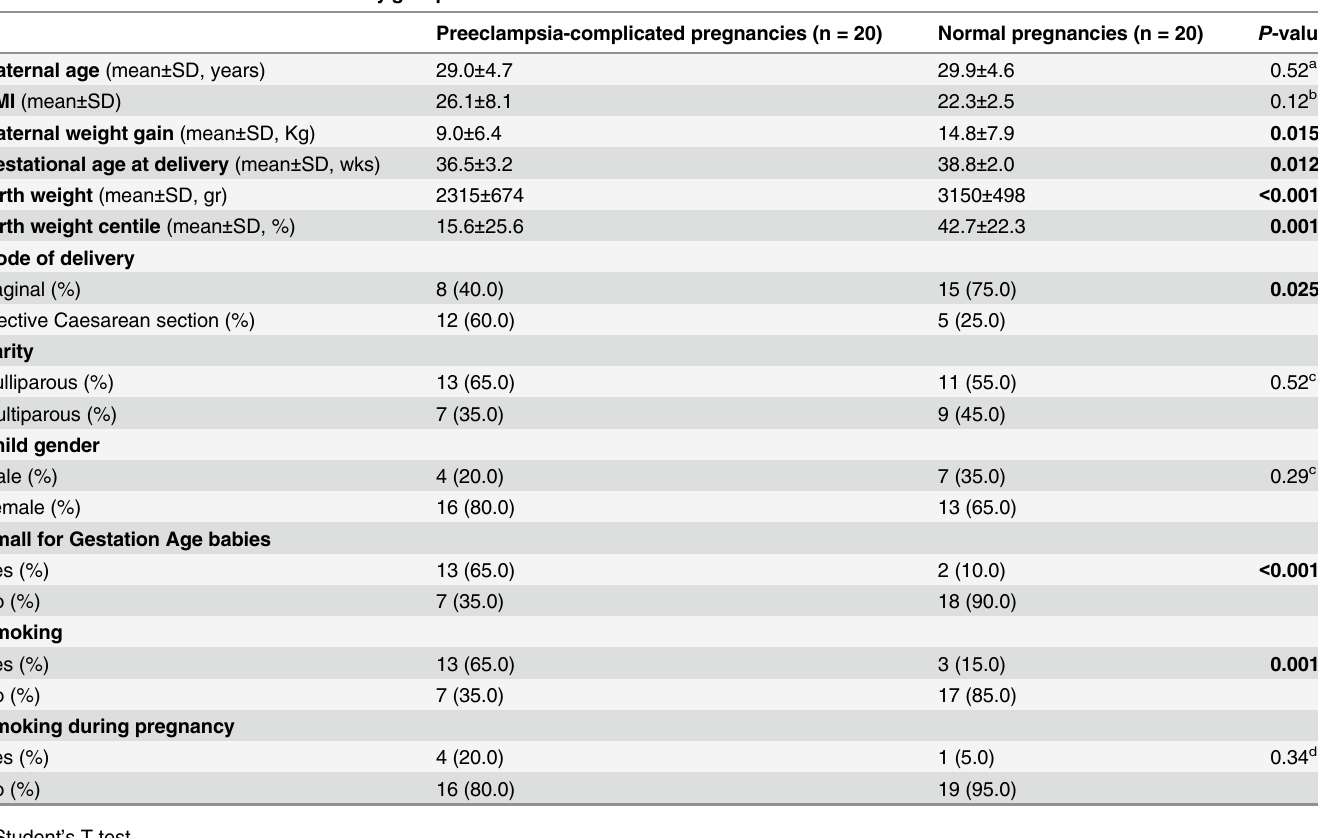
Table 2. Clinical characteristics of the study